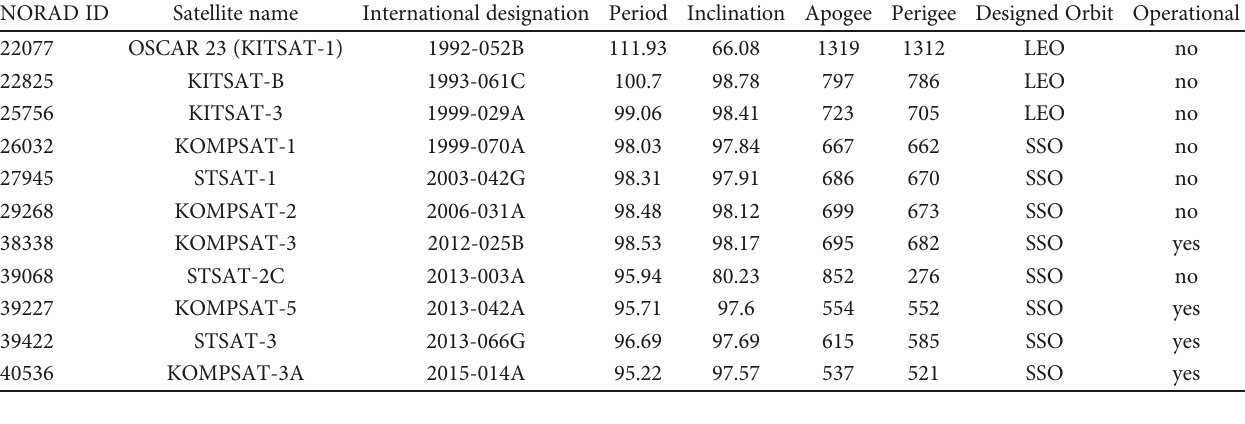
Table 1: Orbital characteristics of 11 Korean LEO satellites on 6 April 2018.